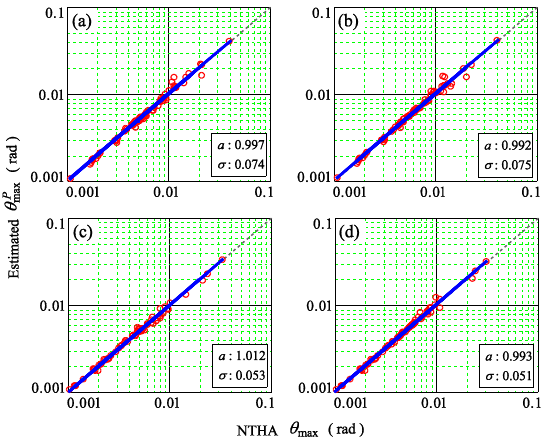
Figure 6. Regressions of θ max on θ P max for a six-story frame with dampers: ( a ) κ = 1.5 and υ = 0.4; ( b ) κ = 1.5 and υ = 0.6; ( c ) κ = 3 and υ = 0.4; and ( d ) κ = 3 and υ = 0.6.